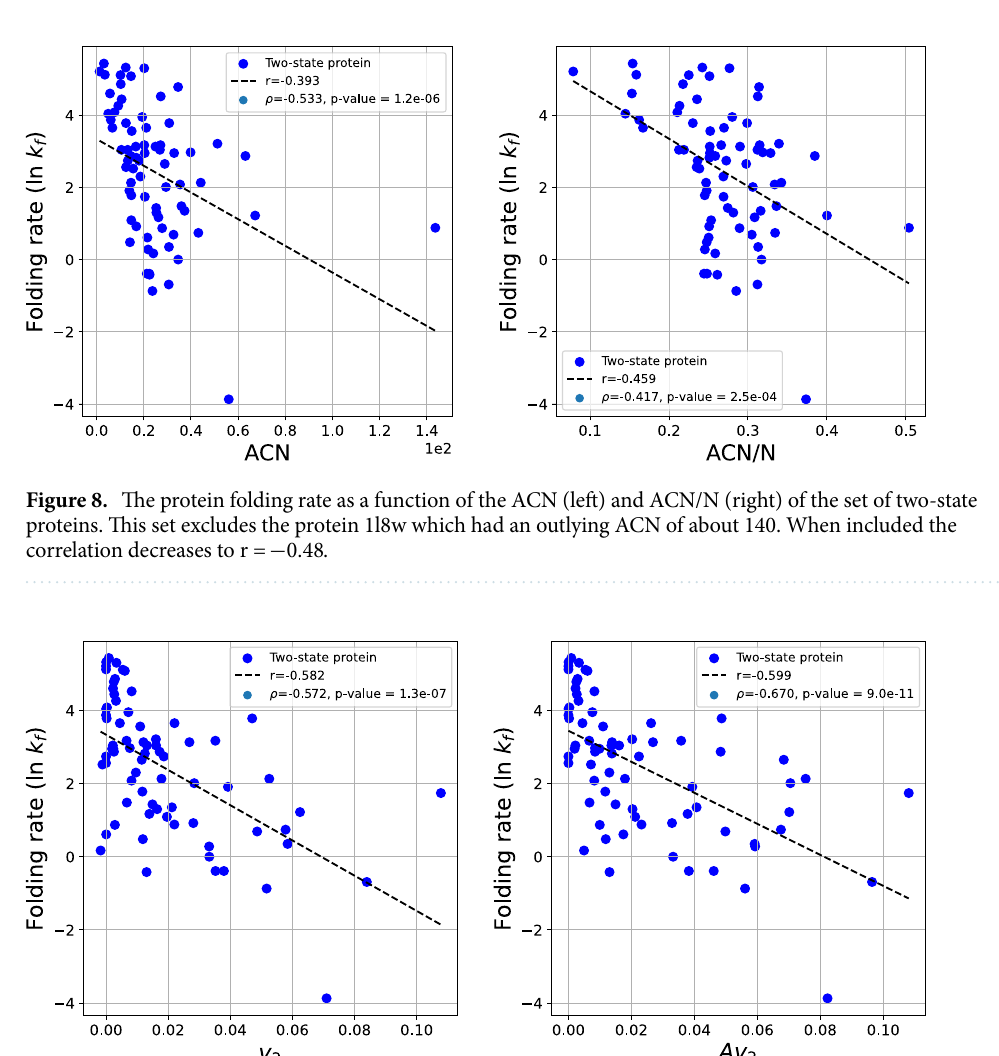
Figure 7. The protein folding rate as a function of the approximate Av 2 (left) and Av 2 /N (right) for both two- state and multi-state proteins.